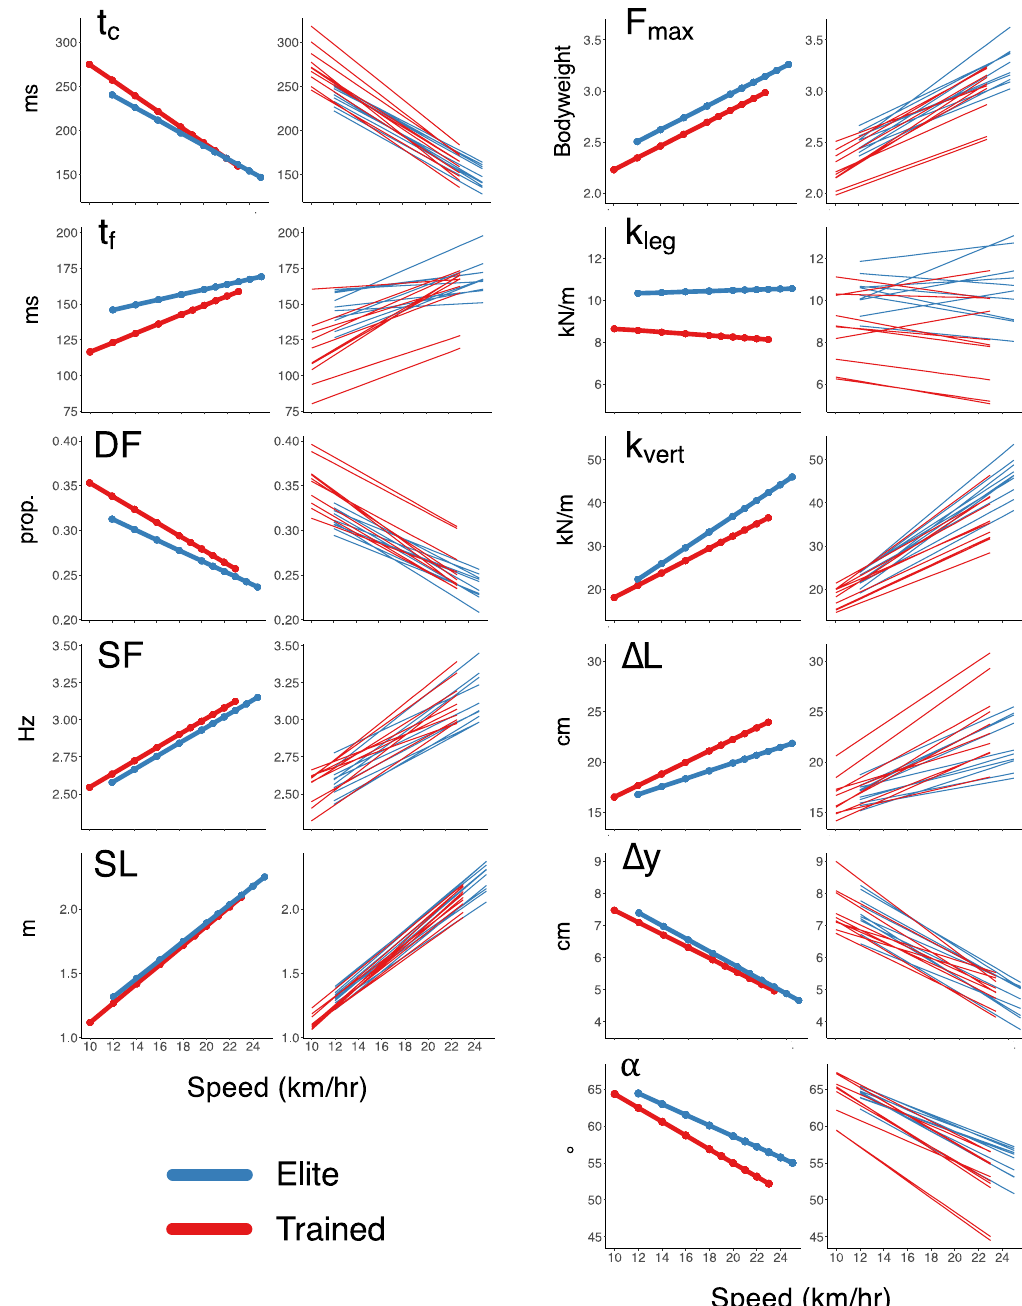
Figure 2. Spatiotemporal and spring-mass characteristics for elite and trained runners across speeds. Population (fixed, left) and individual (random, right) effects given for each